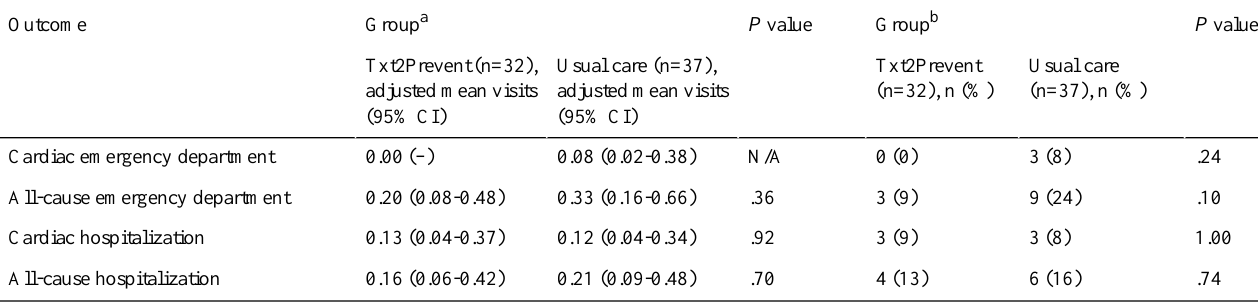
Table 6. Type of and mean hospital visits within 60 days, by